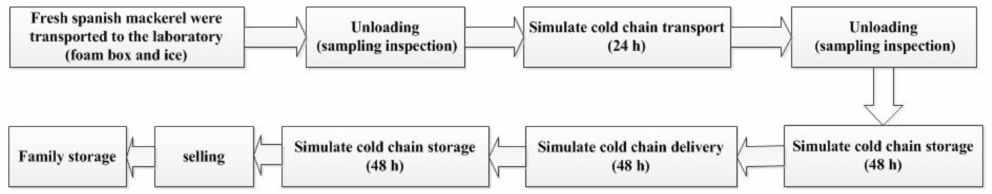
Figure 1. Fresh Spanish mackerel in simulated cold-chain logistics